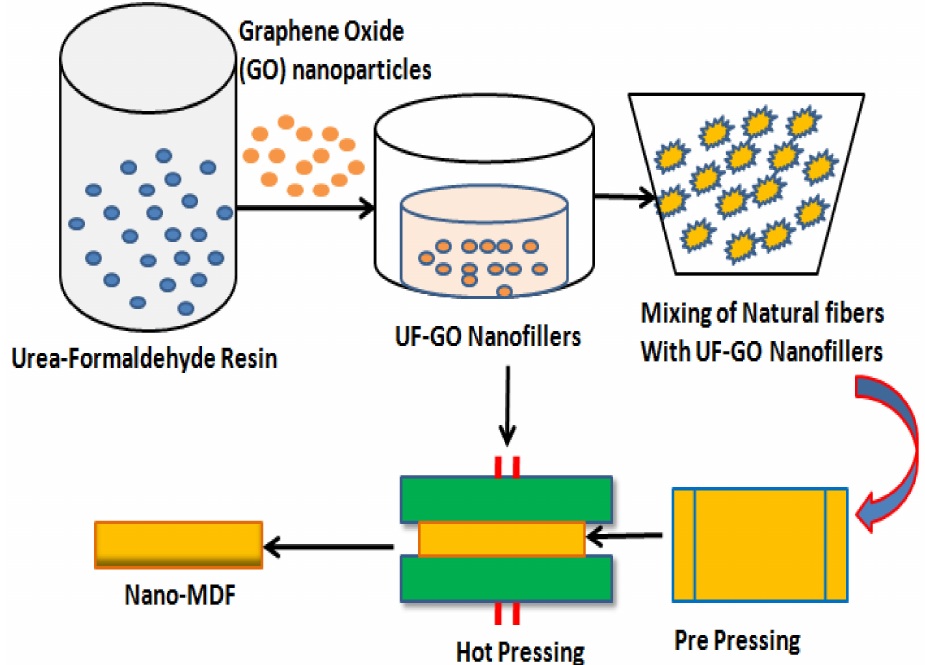
Figure 1. Production process flow of Nano MDF in